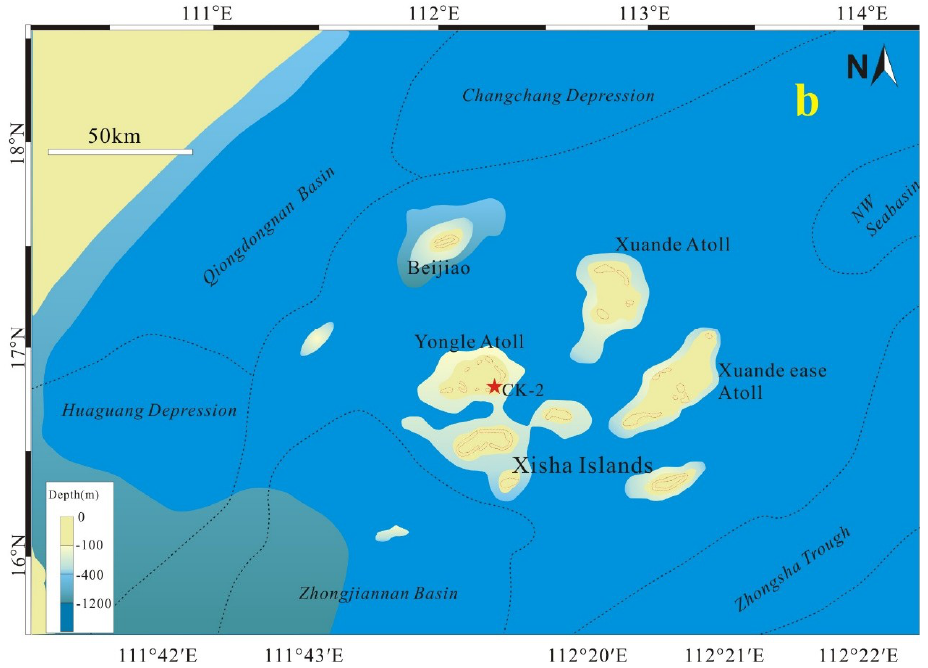
Figure 1. ( a ) Geological sketch of the South China Sea and its adjacent areas; ( b ) location of Well CK-2 (after polarization [7,56]). The depth is below sea level and in meters.